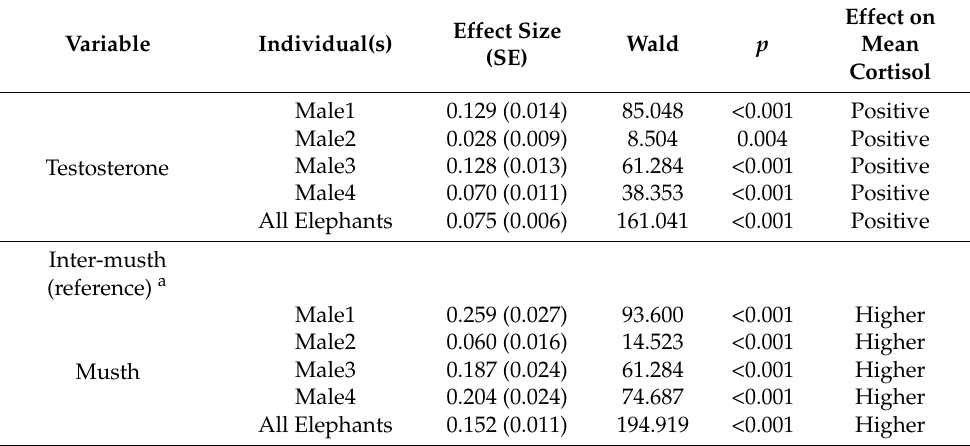
Table 10. Testosterone and musth as a predictor of adrenal glucocorticoid (GC) activity. Fixed effect, effect size with standard error (SE), Wald statistic, p -value from GLMMs, and relative effect of testosterone and musth state on mean cortisol concentrations. Degrees of freedom (df) is 1 in all pair-wise comparisons.